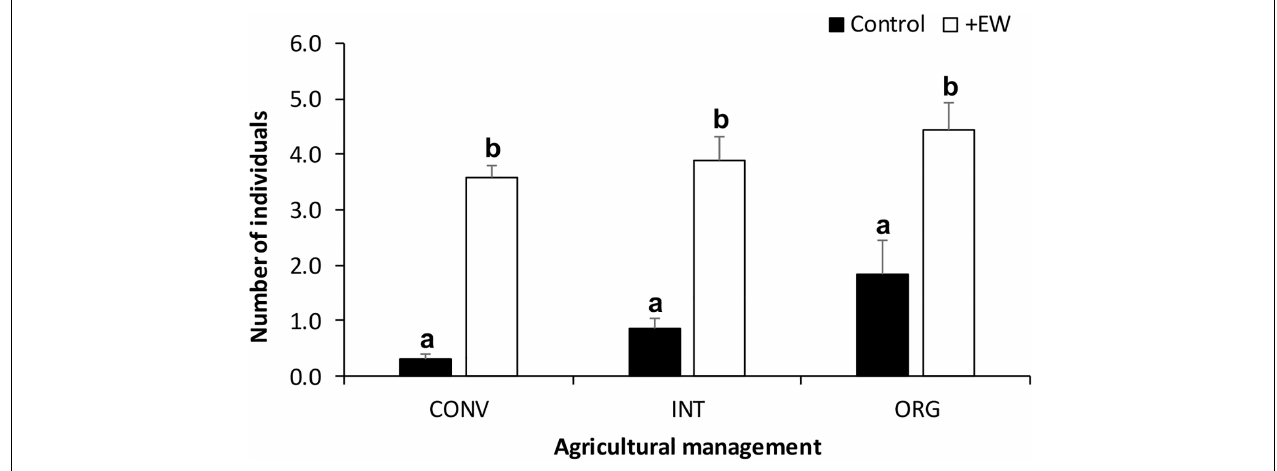
FIGURE 1 | Number of earthworms collected in the soil cores (mean ± S.E.) from each agroecosystem (CONV, INT, and ORG) and incubated during 105 days. Different letters represent significant differences between earthworm treatments per agricultural management treatment ( p < 0.05).